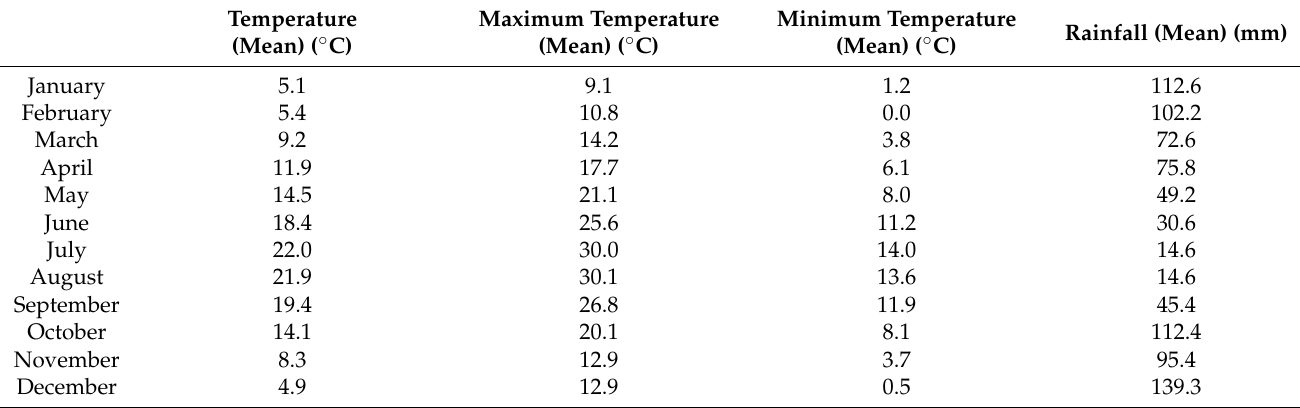
Table 1. Monthly average data on weather conditions in the region during the study period (2009–2014).